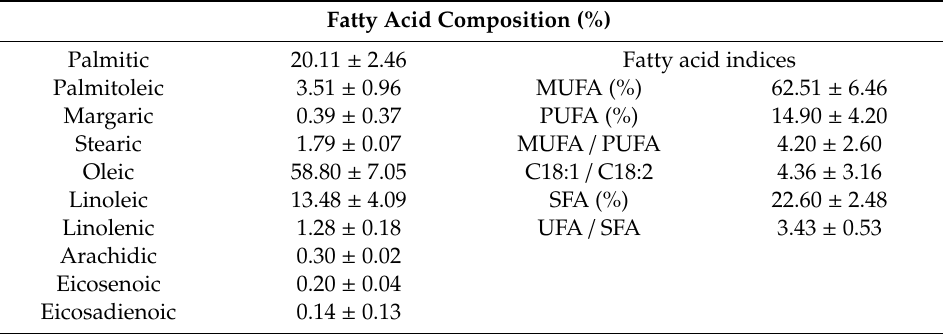
Table 2. Physical and chemical characterization of ivory-white